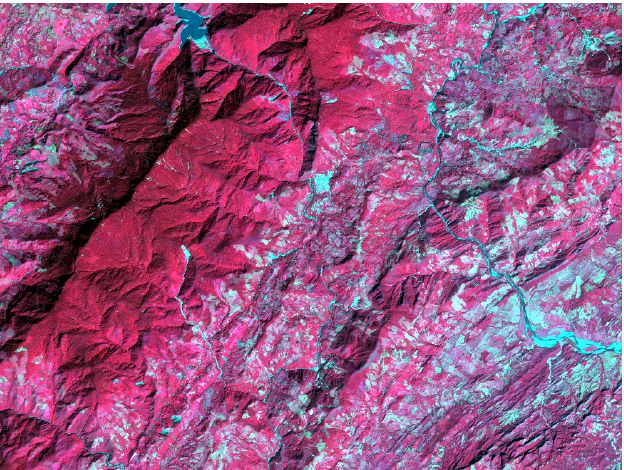
Figure 3. False color NIR, Red and Green composition of the study area using a Sentinel 2A image. The geographical zone covers an area of 300 km 2 . The upper left corner of the zone is placed at 4 ◦ 54 (cid:48) 44.02 (cid:48)(cid:48) N, − 73 ◦ 21 (cid:48) 22.15 (cid:48)(cid:48)